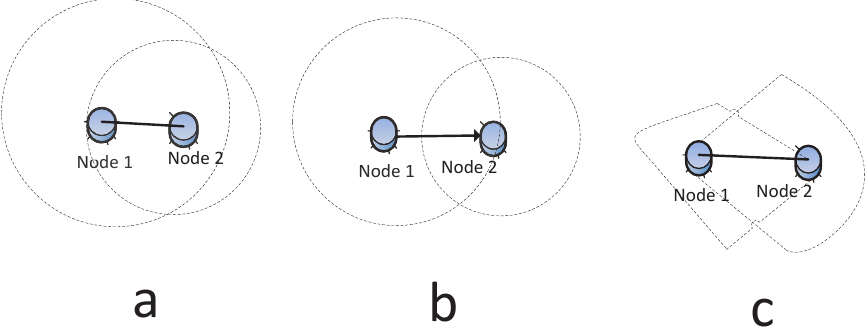
Figure 4. ( a ) Symmetric link: Node 1 can communicate with Node 2 and vice versa ; ( b ) asymmetric link: Node 1 can send data to Node 2, but Node 2 cannot send data to Node 1; ( c ) non-omnidirectional